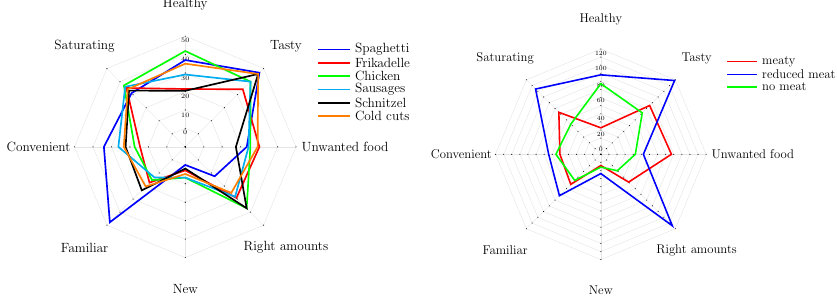
Figure 5. Radar diagram showing the total counts of reasons for choosing a variety (meaty, reduced meat, no meat) of the respective dishes (Spaghetti, Frikadelle, chicken drumsticks, sausages, Schnitzel, and cold cuts). Left: Reasons in term of the dish; right: Reasons in term of the